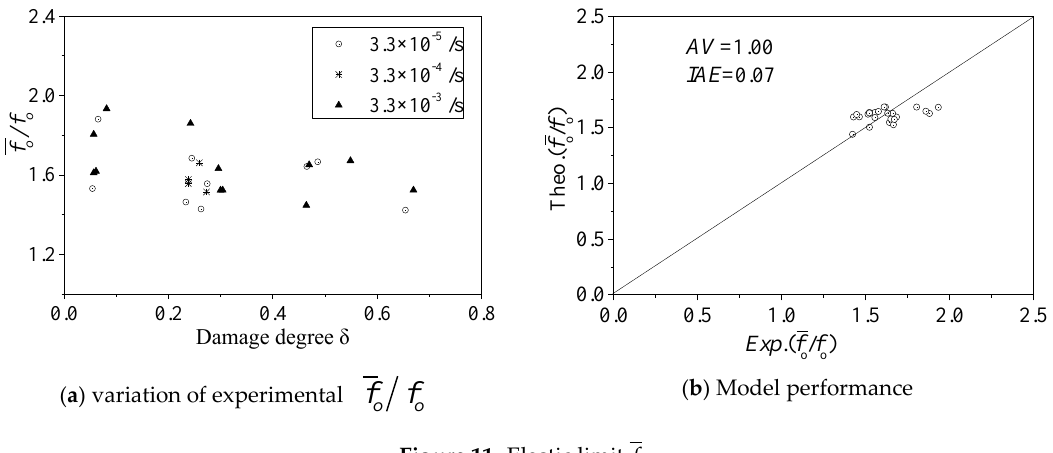
Figure 11. Elastic limit o